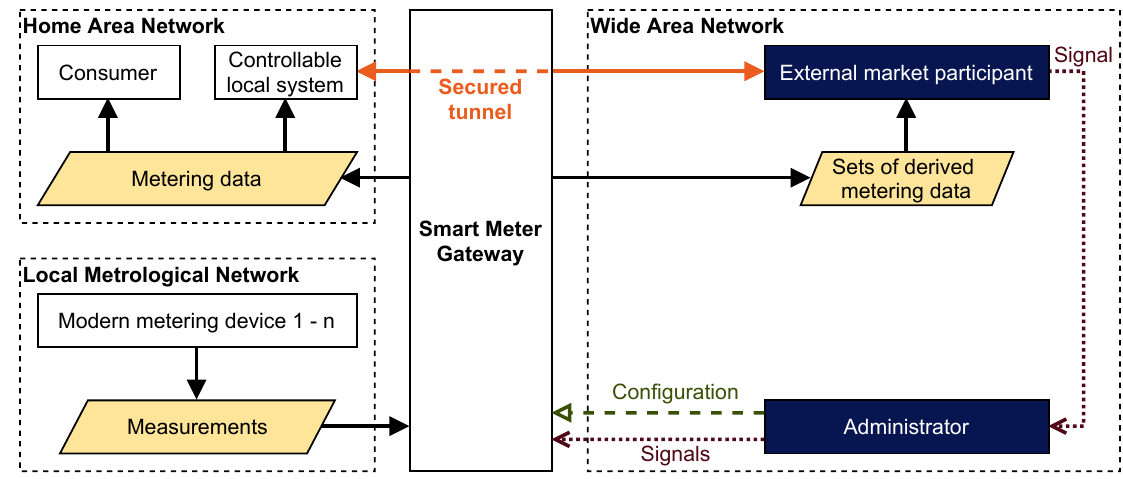
Figure 1. Communication in the local metrological network (LMN), home area network (HAN), and wide area network (WAN) based on